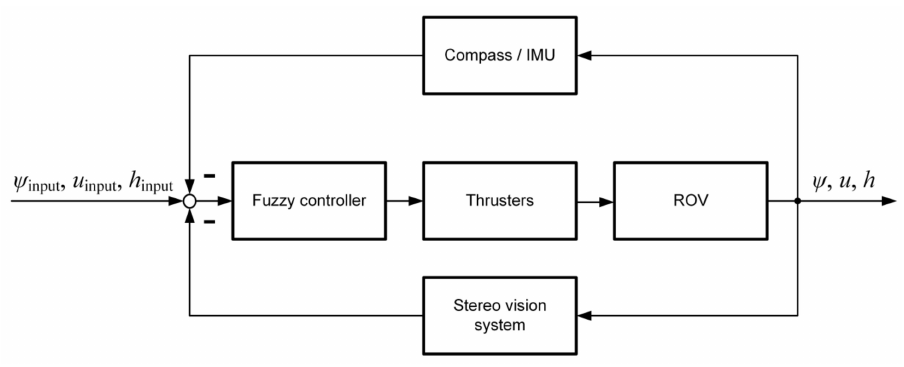
Figure 11. Control